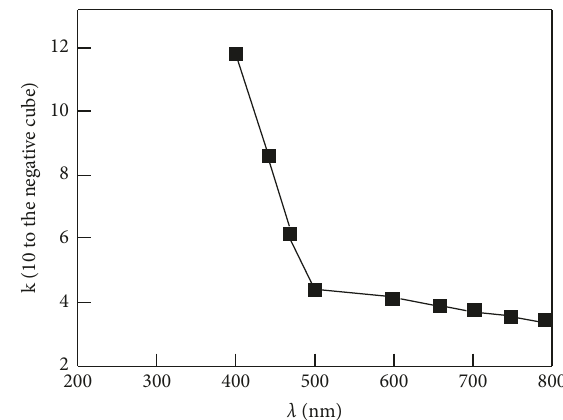
Figure 6: Dispersion curves of extinction coefficient k of nano- material samples.